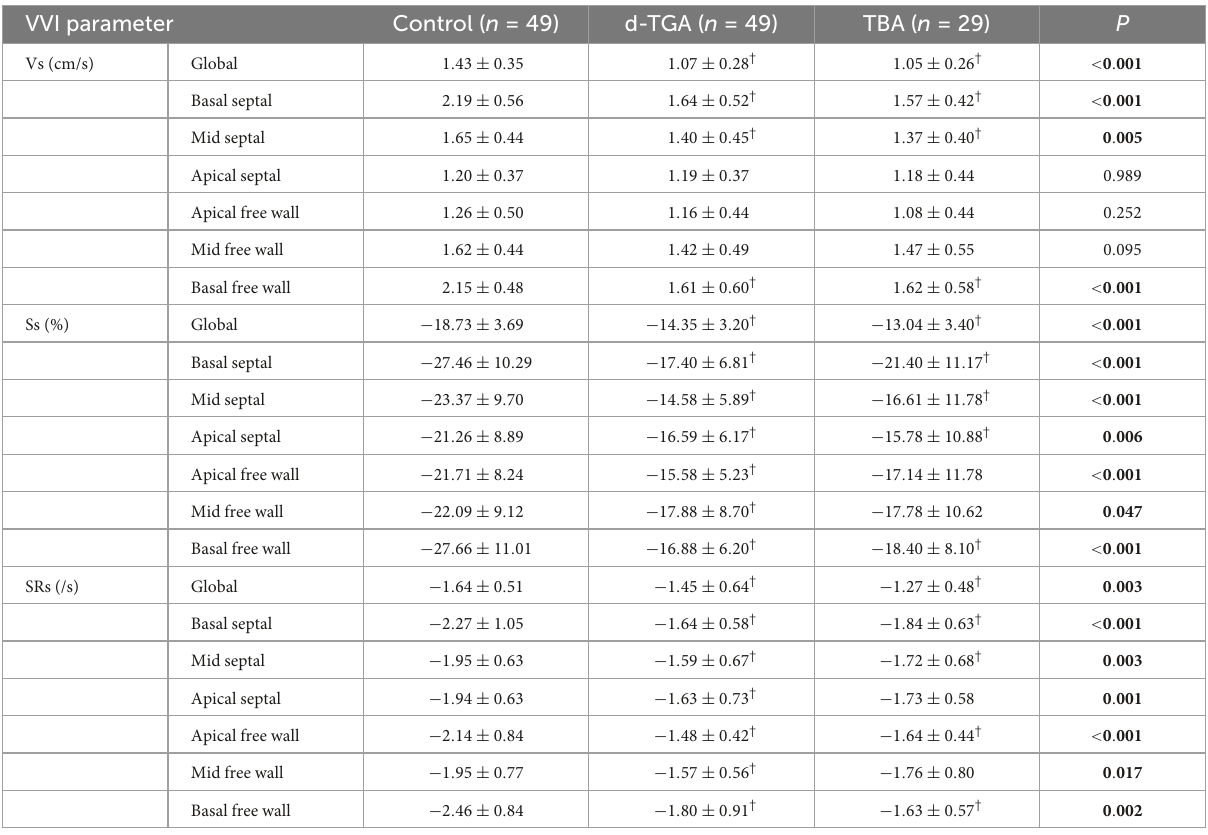
TABLE 3 Global and segmental deformation analysis of right